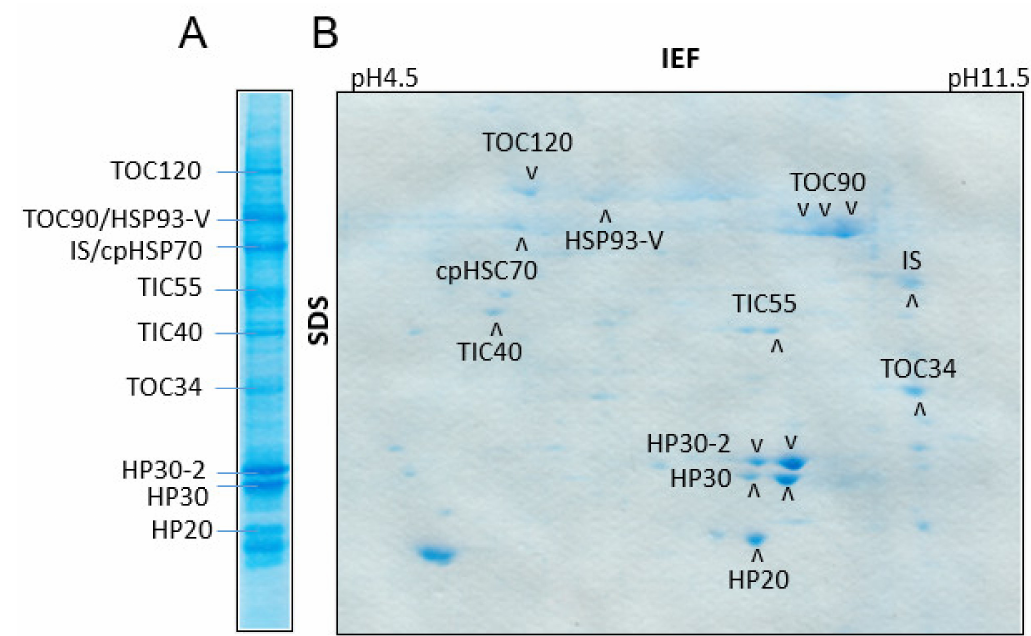
Figure 1. Identification of HP20 and HP30 as components operating in the import of transit sequence-less proteins into chloroplasts. ( A ) One-dimensional pattern of import intermediate-associated proteins (IAPs) formed with 35 S-ceQORH- (His) 6 . ( B ) as ( A ), but showing a two-dimensional separation comprising isoelectric focusing (IEF) in the first dimension (from left to right) and SDS-PAGE gradient gel electrophoresis (SDS), from top to bottom, in the second dimension. Proteins were stained with